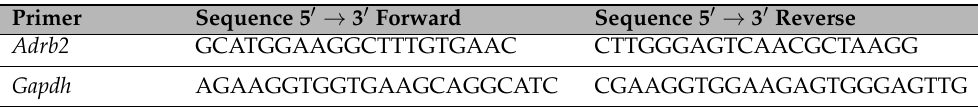
Table 2. Primers used for RT-PCR to study spinal cord expression of adrenoceptors.